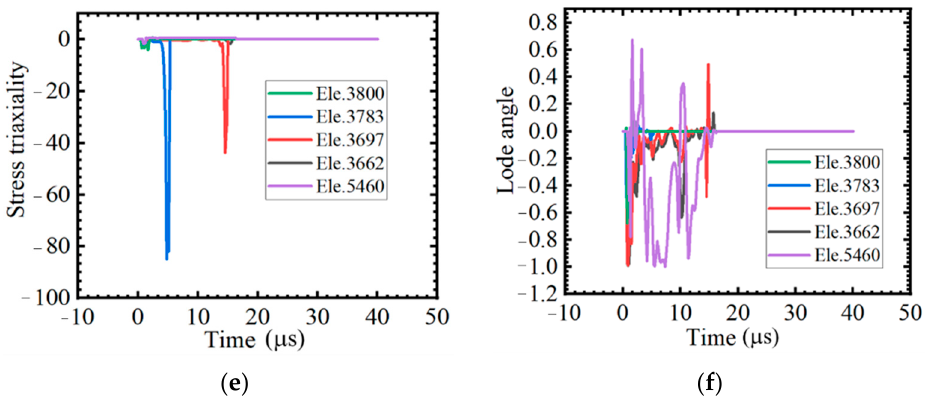
Figure 12. Changes in some history variables over time. ( a ) Different element locations. ( b ) PEEQ. ( c ) Temperature. ( d ) Damage. ( e ) Stress triaxiality. ( f ) Lode angle.